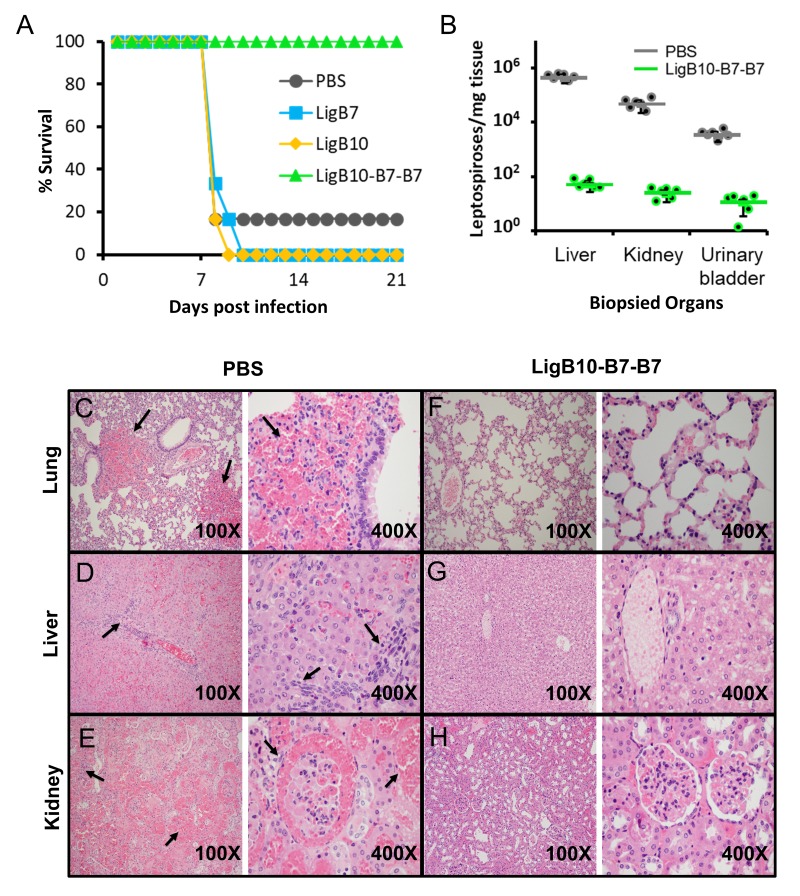
Leptospira lethal challenge of hamsters immunized with LigB Ig-like domains.(A) Survival rates for groups of six immunized hamsters are shown for the 3 weeks post leptospiral challenge. Inoculations and boosters with specific LigB Ig-like domains occurred 3 and 6 weeks prior to leptospiral infection. Sera from immunized hamsters were tested for domain-specific immunoreactivity (Figure 7—figure supplement 2). (B) The indicated organ tissues were biopsied from post-challenged hamsters immunized with PBS (control) or LigB10-B7-B7. The leptospiral load of hamster tissue was determined by RT-qPCR for the Leptospira specific gene, LipL32. Each point depicts the mean value obtained from duplicate analysis of individual tissue samples. Bars indicate the mean bacterial loads ± S.D. (six hamsters per group). Leptospiral loads for the PBS group are significantly higher than those of the LigB10-B7-B7 group in all three tissues. (C-H) Post-challenged hamster tissues that are targets for spirochete infection were fixed by formalin and stained by hematoxylin and eosin. PBS (control) immunized hamster tissue exhibited (C) multifocal lung hemorrhage, (D) liver inflammation and necrosis, and (E) tubulointerstitial nephritis and hemorrhage in the kidneys (each indicated by arrows). (F-H) Tissue from the LigB10-B7-B7 immunized group were all within normal limits.